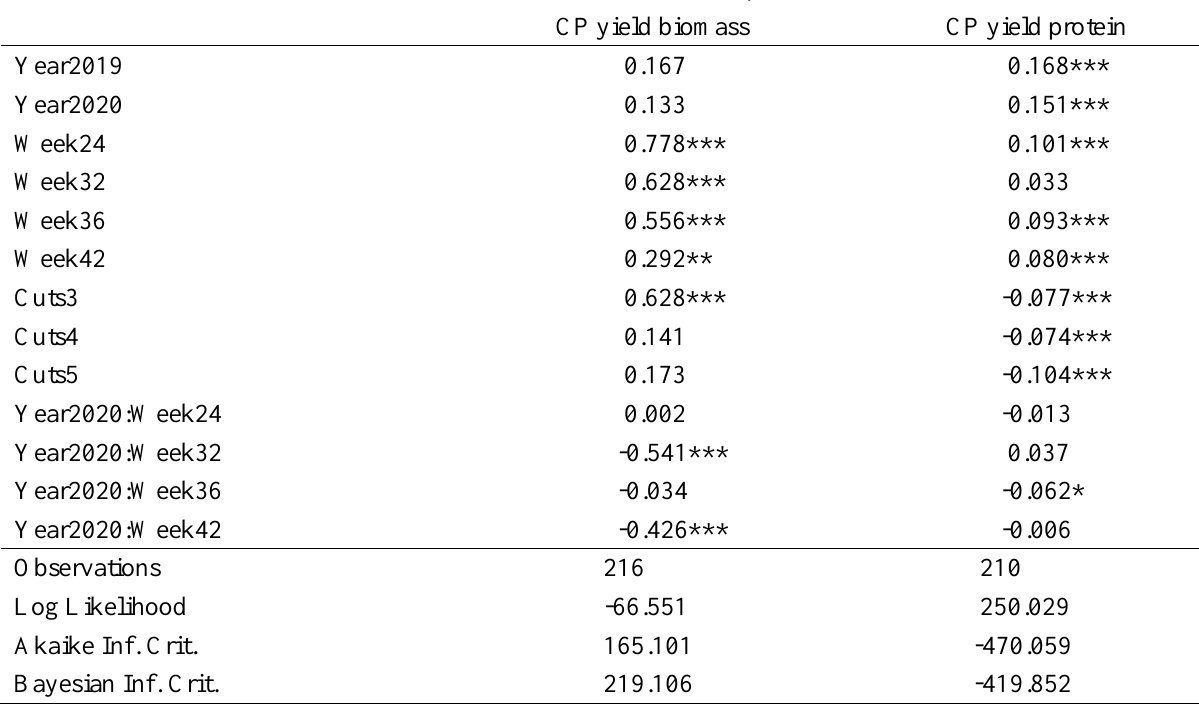
Table A3. Linear mixed effects model outcomes for the effects of years (Year), harvest timing (Week) and the different harvest intensities (Cuts) for crude protein (CP) yield in biomass and in the protein precipitate. Significance codes: * = p < 0.05; ** = p < 0.01; *** = p < 0.001.